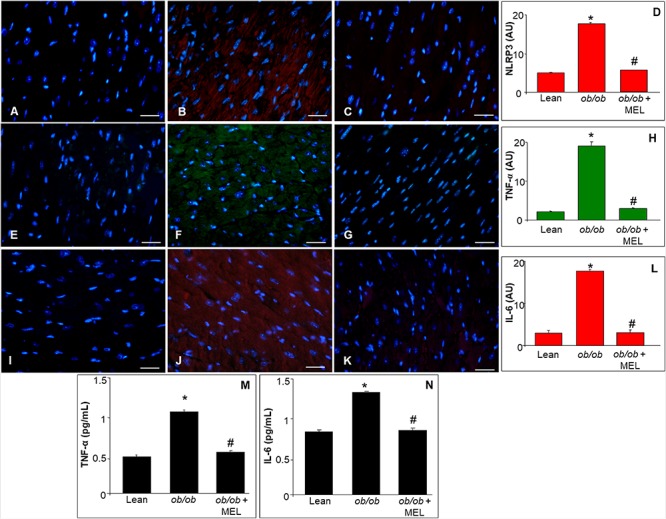
Immunofluorescence photomicrographs of NLRP3 inflammasome (A–C), TNF-α (E–G), and IL-6 (I–K) expression at heart level of lean (A,E,I), ob/ob mice (B,F,J), and ob/ob mice supplemented with melatonin (C,G,K). Scale bar: 20 μm. The graphs summarize the immunomorphometrical measurement of NLRP3 (D), TNF-α (H), and IL-6 (L) and serum TNF-α (M) and IL-6 (N) levels. *p≤0.05 vs lean mice and #p≤0.05 vs ob/ob mice. IL-6, interleukin-6; MEL, melatonin; NLRP3, nucleotide oligomerization domain like receptor 3; TNF-α, tumor necrosis factor-alpha.